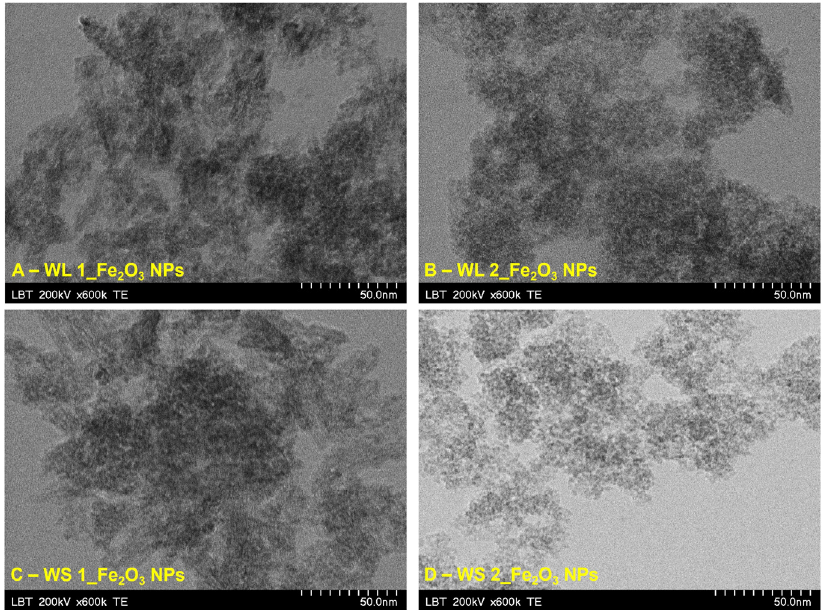
Figure 9. TEM images of IONPs obtained from WL aqueous extract: ( A ) Fe 2 O 3 NPs from WL at 80 °C, ( B ) Fe 2 O 3 NPs from WL at 25 °C and WS aqueous extract: ( C ) Fe 2 O 3 NPs from WS at 80 °C, ( D ) Fe 2 O 3 NPs from WS at 25 °C.